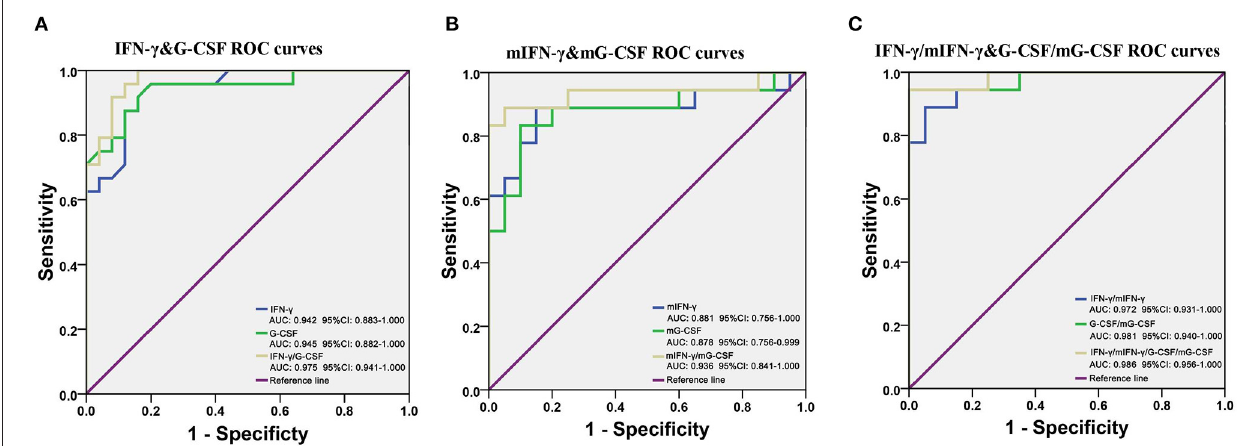
FIGURE 4 | G-CSF and IFN- γ as potential biomarkers for SCZ. (A) ROC curves are utilized to evaluate the accuracy of the serum G-CSF and IFN- γ levels for differentiating between FEDF patients with SCZ and HC subjects. (B) ROC curves are utilized to evaluate the accuracy of blood G-CSF and IFN- γ mRNA levels for differentiating between FEDF patients with SCZ and HC subjects. (C) ROC curves are utilized to evaluate the accuracy of combining cytokine mRNA and protein levels for differentiating between FEDF patients with SCZ and HC subjects. Receiver operating characteristic (ROC) curves were used to evaluate the accuracy in serum cytokines for the differentiation between SCZ patients and HC subjects, and the area under the curve (AUC) was calculated to evaluate the accuracy of the test. SCZ, schizophrenia; ROC, receiver operating characteristic; FEDF, first-episode, drug-free; HC, healthy control; IFN, interferon; G-CSF, granulocyte colony-stimulating